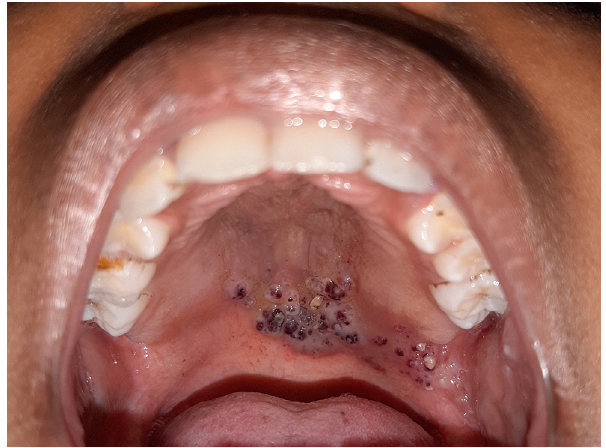
Fig. 1. Clinical image of the palate showing multiple purplish red papules.